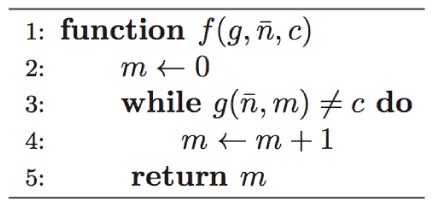
The classical

-operator (adapted from
[30]
).